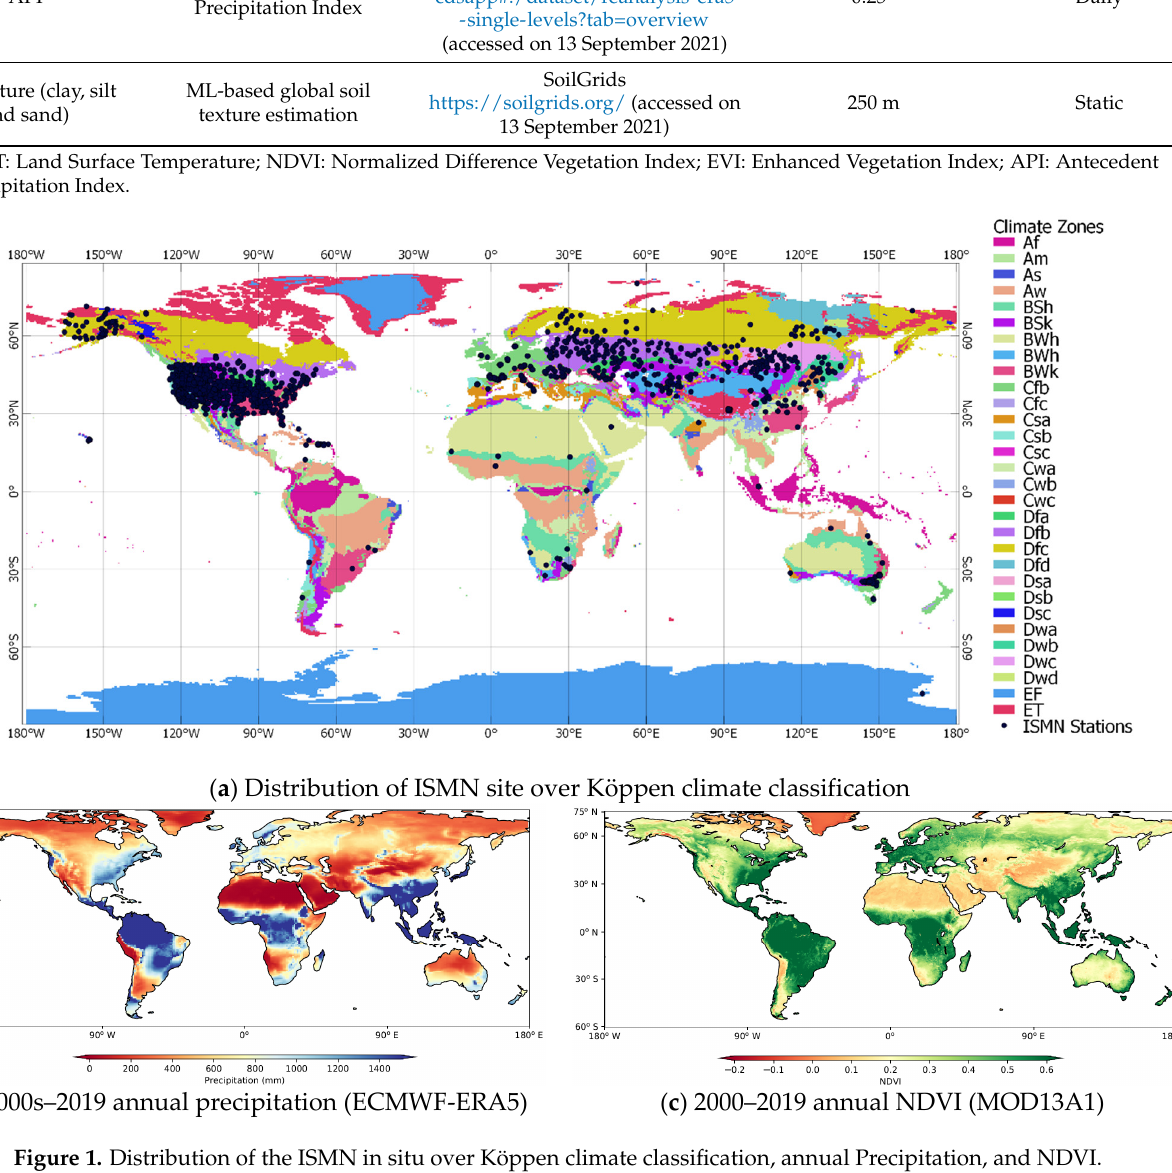
Table 1. Land Surface Features and Data Sources List.